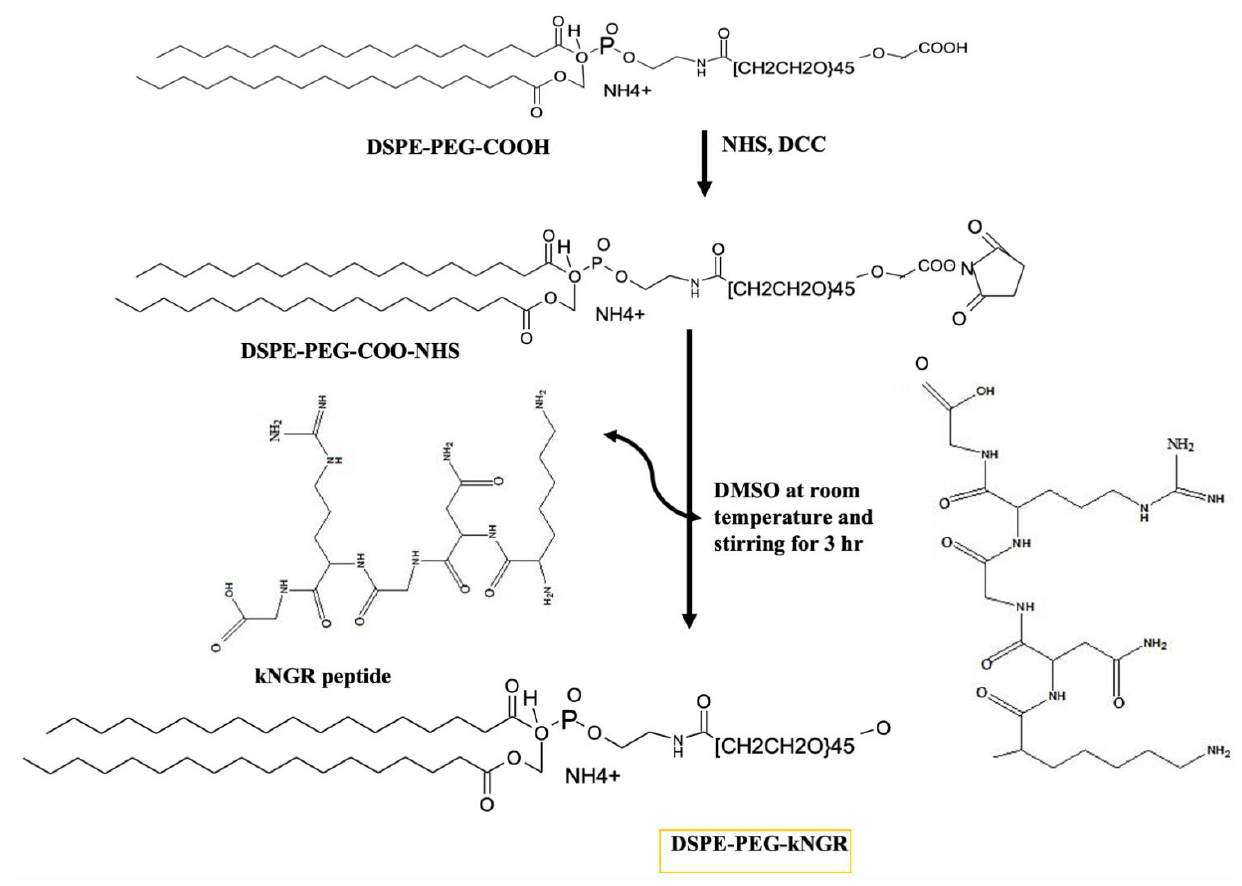
Figure 2. Graphical scheme of synthesis of the DSPE-PEG-kNGR conjugate.